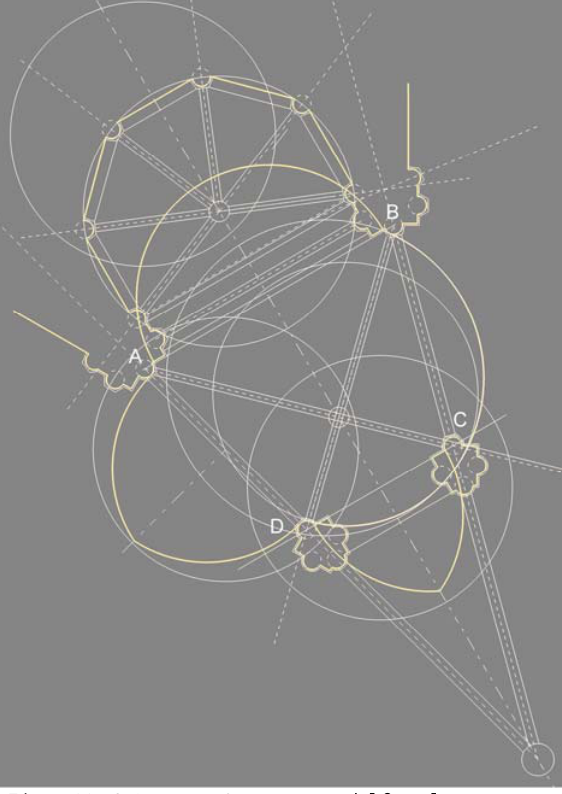
Figure 11. S. Lorenzo, Geometry model from laser scanner